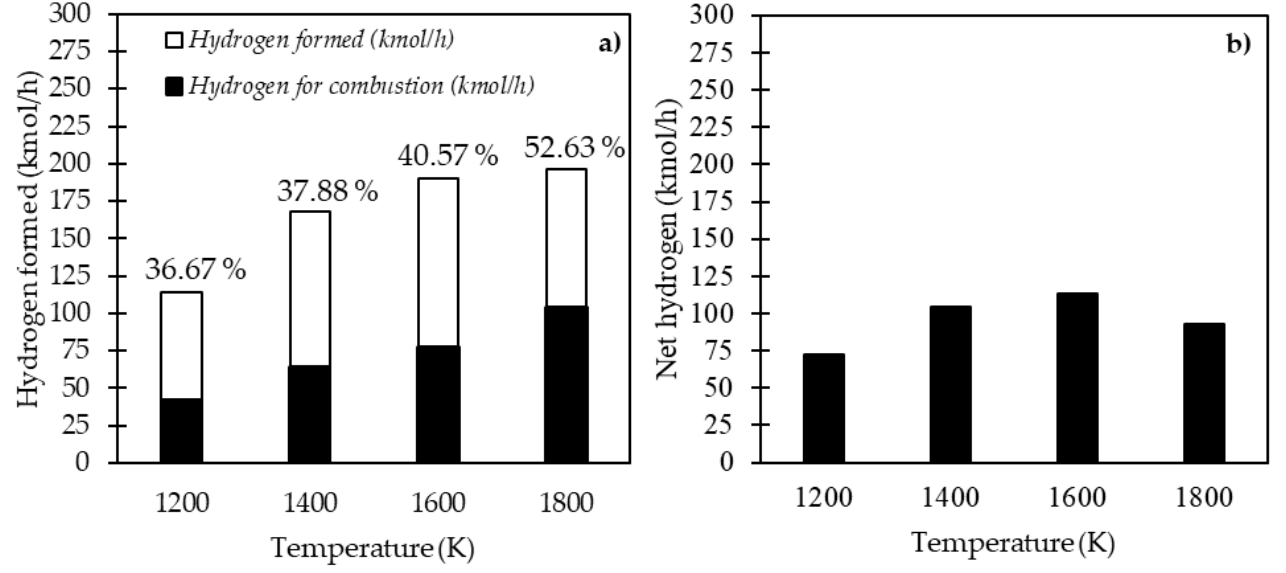
Figure 14. Rates of hydrogen formation and consumption for energy generation through hydrogen combustion ( a ) and net hydrogen ( b combustion ( a ) and net hydrogen ( b ).